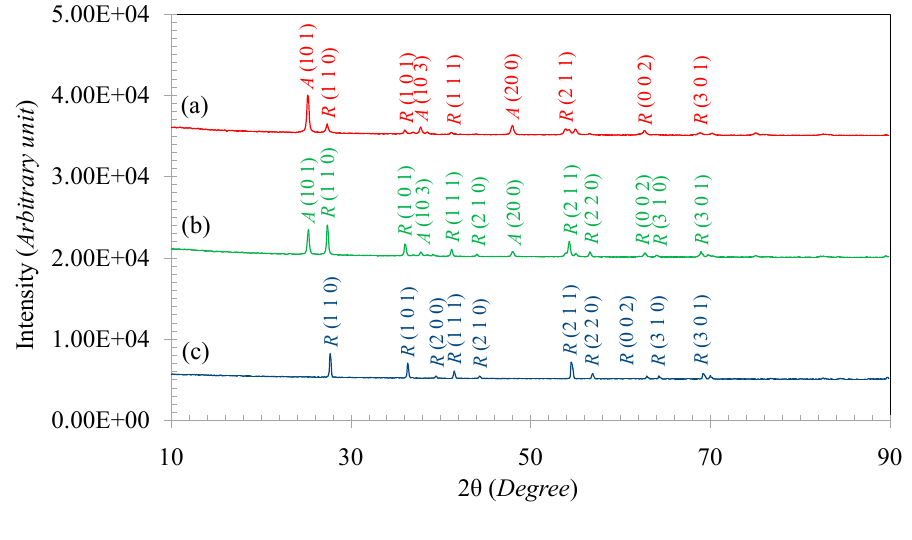
Table 1. Characterization of TiO Treatment of the